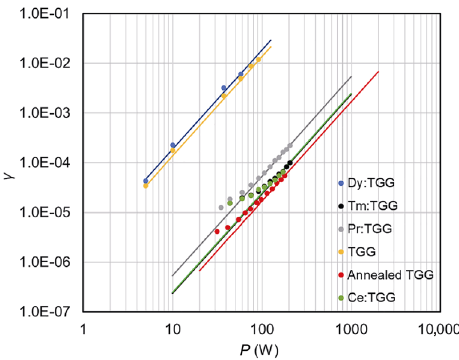
Fig. 6 Experimental (dot) and theoretical (line) dependences of integral thermally induced depolarization on the laser radiation